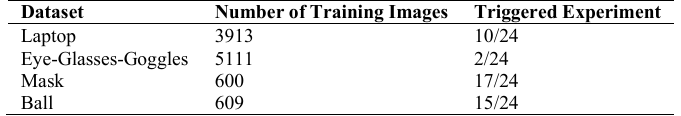
TABLE 8 A NALYSIS OF THE EFFECT OF THE NUMBER OF SAMPLES IN DATASETS ON EARLY